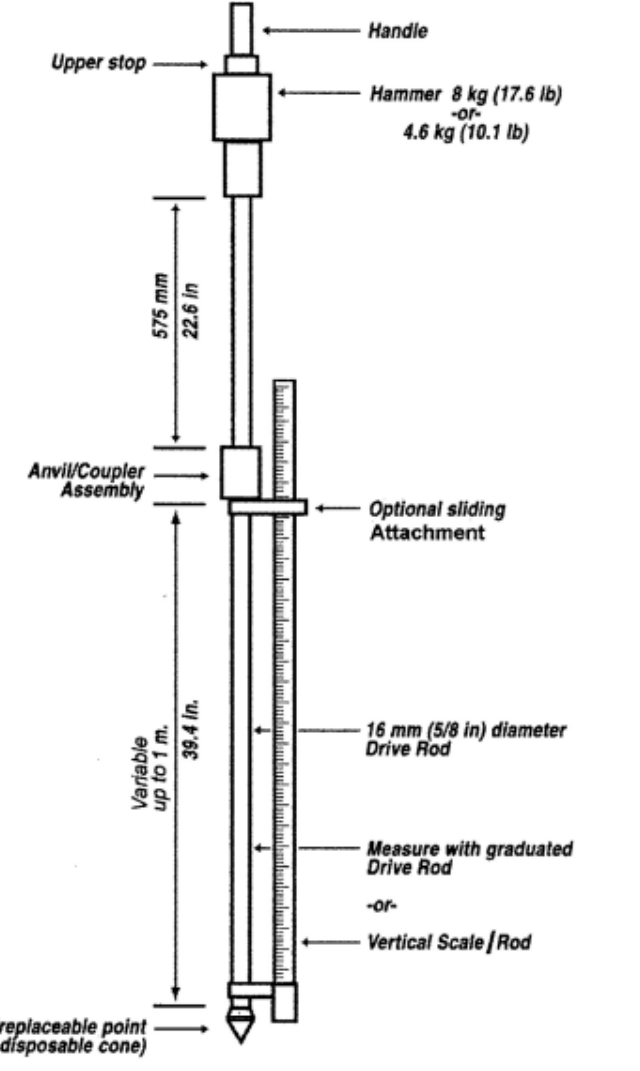
Figure 1. Schematic diagram of Dynamic Cone Penetrometer device (ASTM D5951/D5951M ‐ 18).